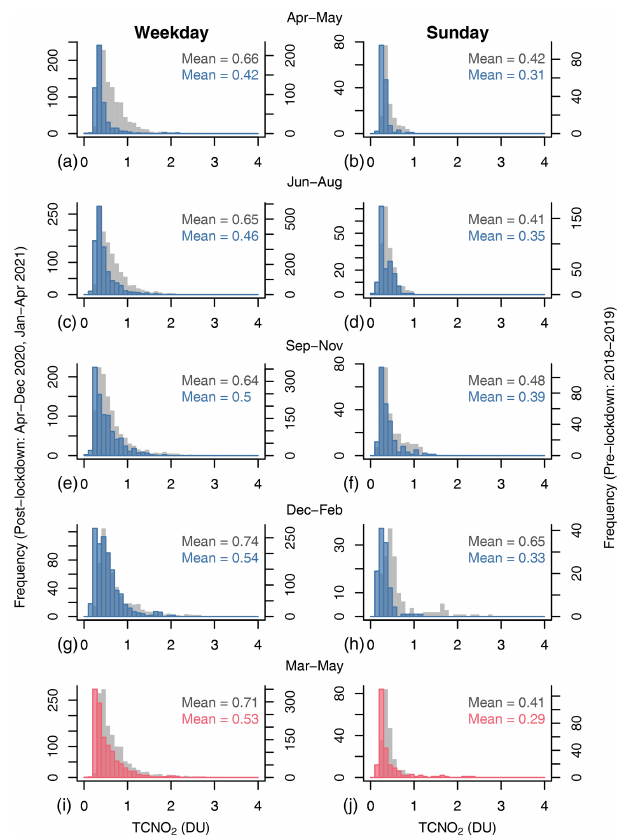
Figure 6. Histogram of TCNO 2 measured in Upper West Man- hattan by PSI#135 for pre-lockdown (gray, 2018–2019) and post- lockdown winter (blue) and post-lockdown spring (pink) condi- tions. Results are shown for weekdays (left column) and Sunday (right column) across seasons from April 2020–May 2021. The mean NO 2 pre- and post-lockdown is also shown.